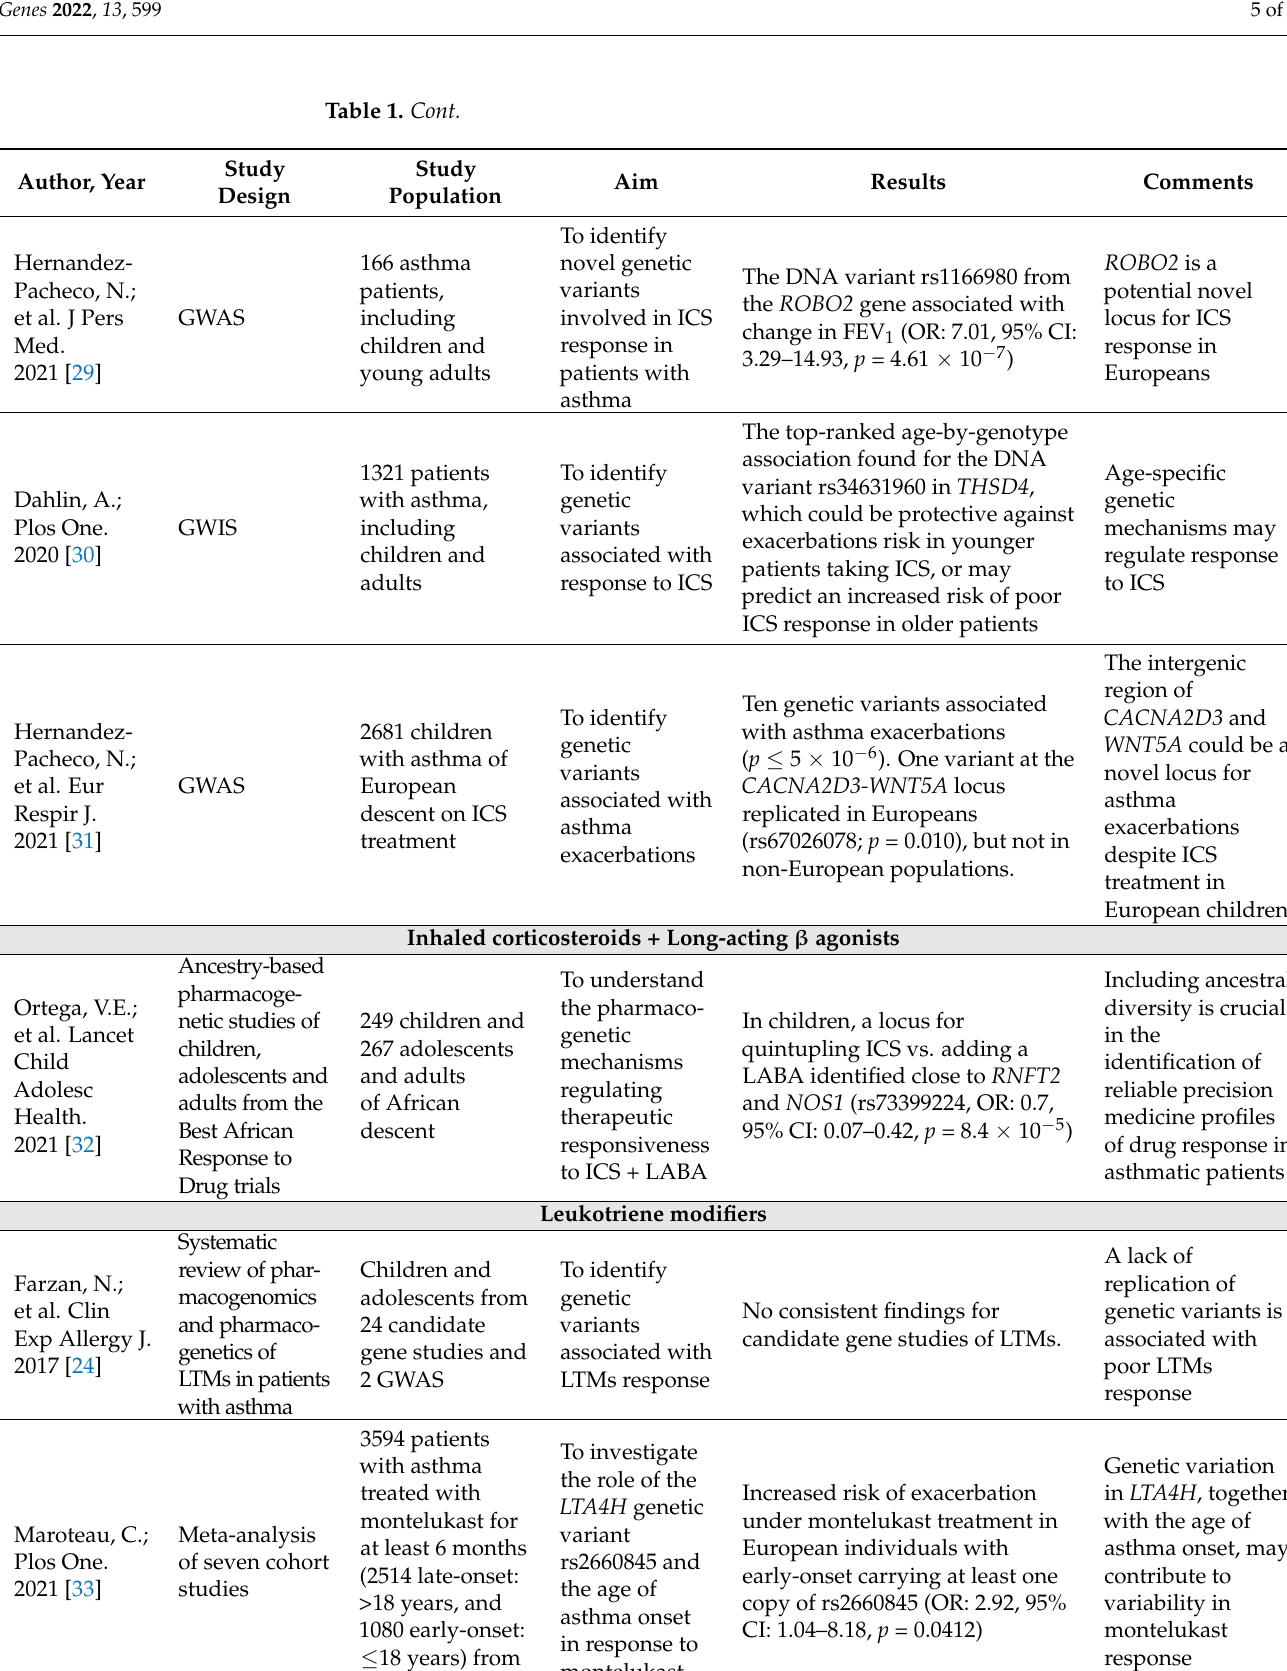
Genetic variation in LTA4H , together with the age of asthma onset, may contribute to variability in montelukast